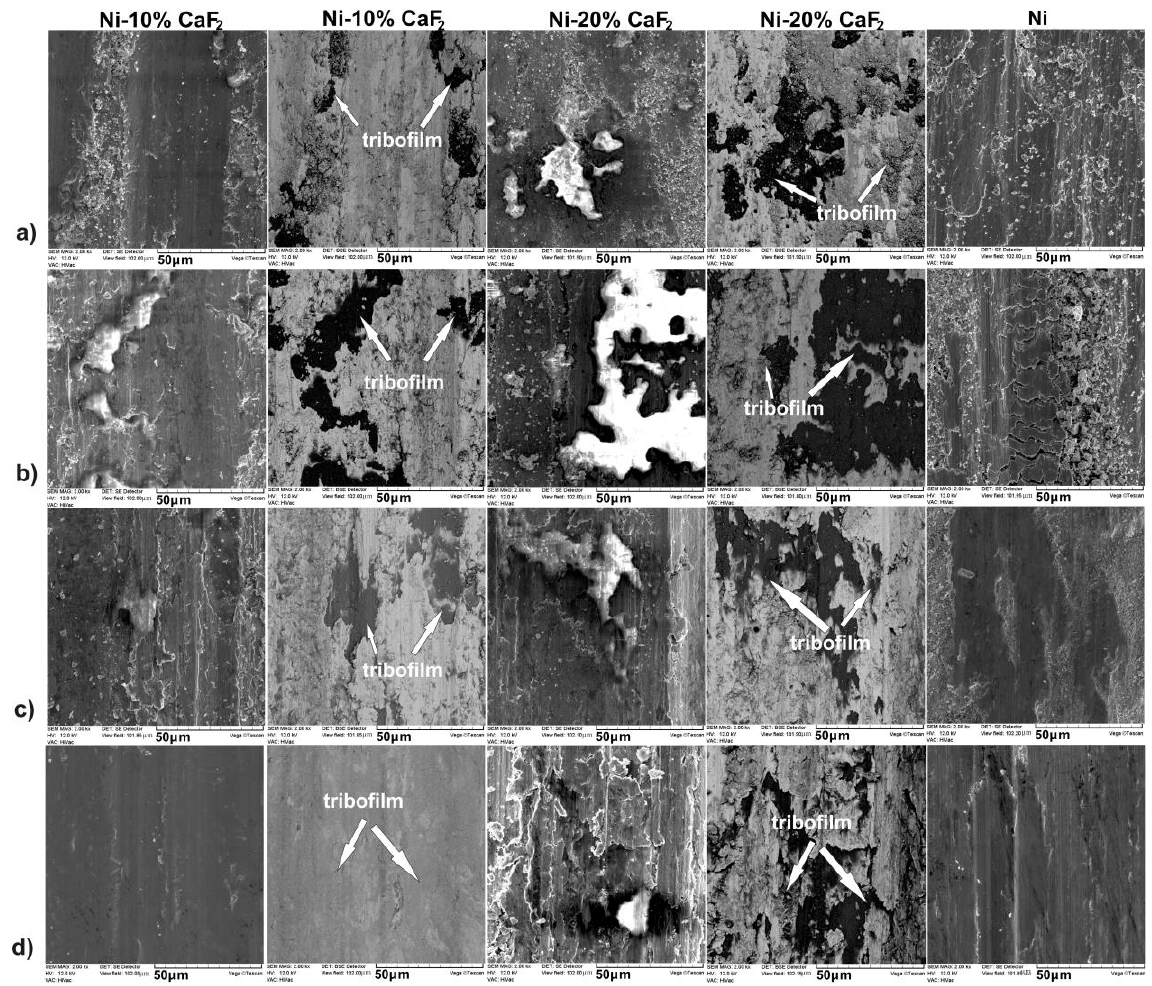
Figure 4. The surface of the worn samples tested at 23 °C ( a ), at 200 °C (473 K) ( b ), at 400 °C (673 K) ( c ), at 600 °C (873 K) ( d ). Results for pure Ni and for 20% addition of CaF 2 were taken from previous work [43] and added for data clarity. White arrows indicate places where the tribofilm was produced during friction.